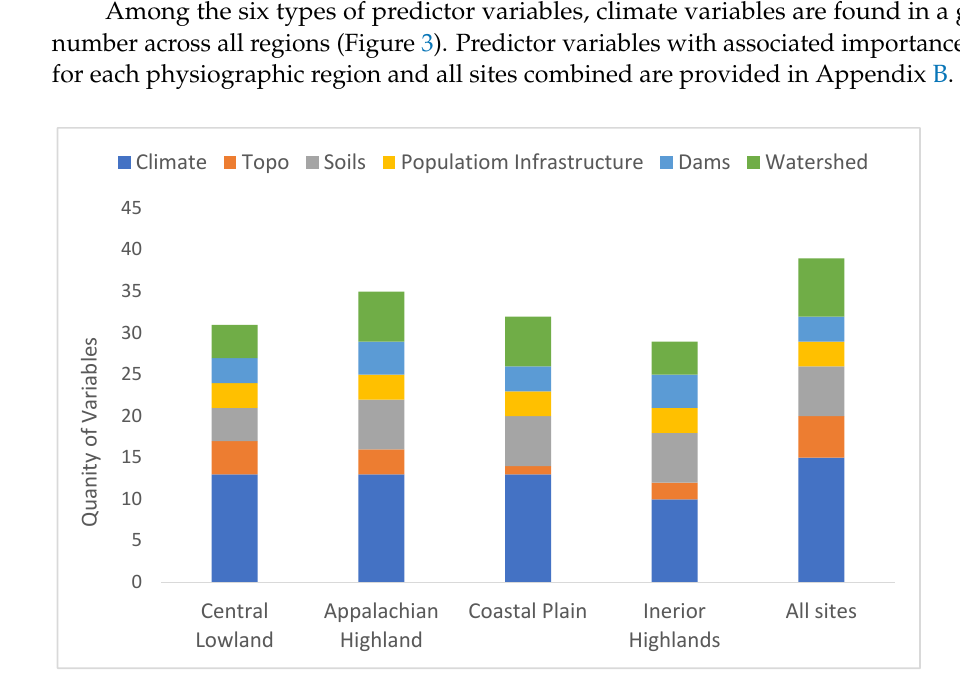
Figure 3. Types of predictor variables across different physiographic regions .